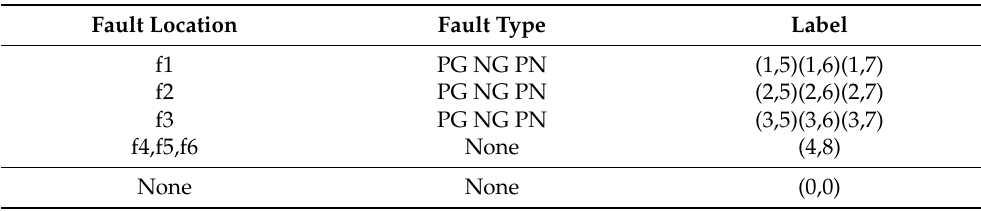
Table 4. Tagging